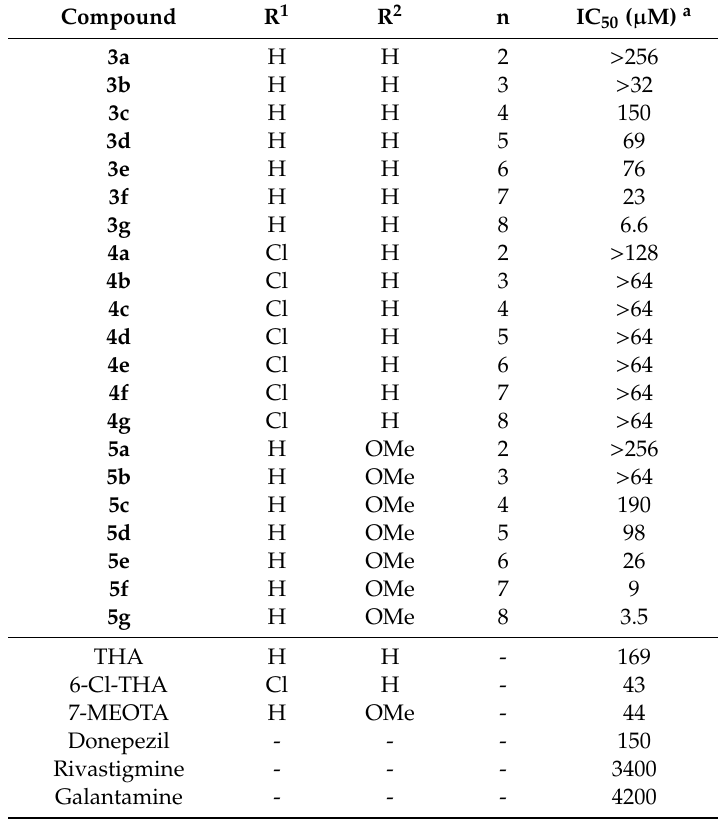
Table 2. Cytotoxicity of tacrine-squaramides evaluated using HepG2 cells measured by colorimetric MTT